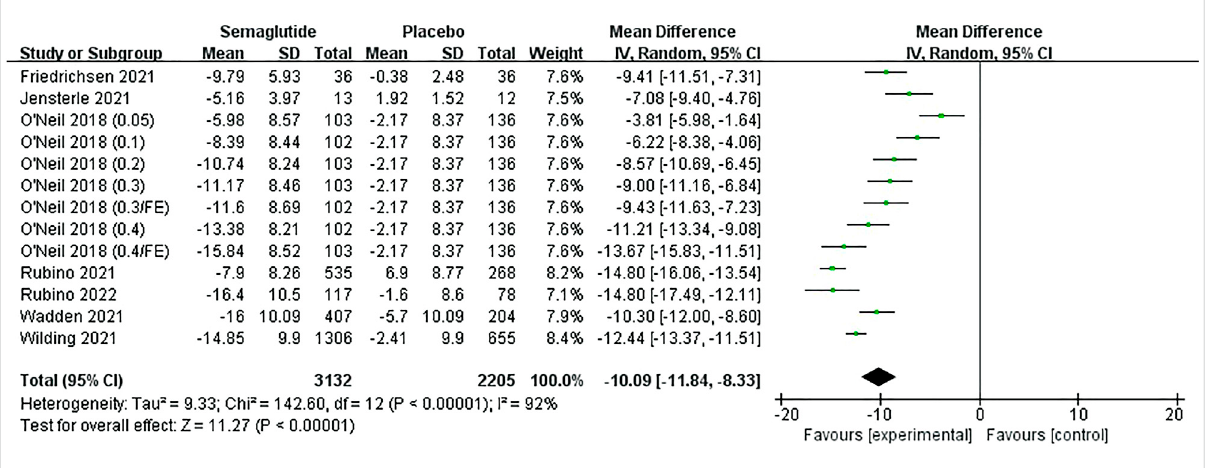
FIGURE 4 Meta-analysis results of RBW change (%) in included trials.